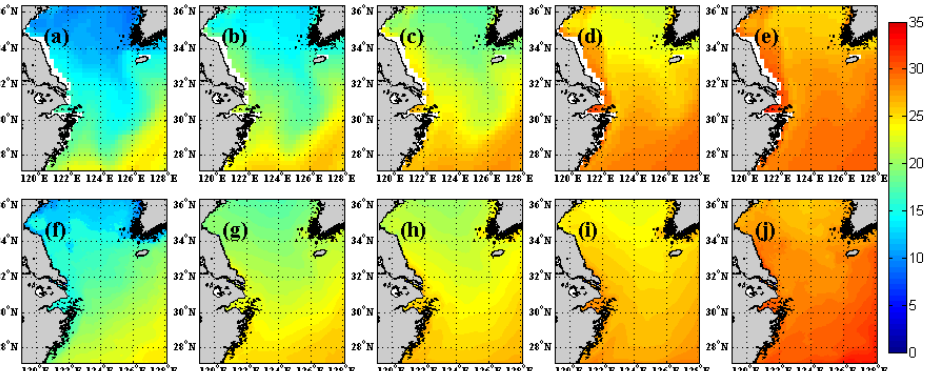
Figure 3. Monthly SST of ECCO2 from April to August (13-year average from 1998–2010) of Yangtze River estuary ( a – e , top row). The ( f – j ) are the same as ( a – e ), but for the model results. In addition to the spatial pattern, we also compare the time series of SST from model and ECCO2 averaged over 29° N – 32° N, 122.5° E – 124° E, which is a region where harmful algal bloom events happen frequently [47,50]. The model and ECCO2 (Figure 4) both show the gradual increase of SST from April to August, whereas the model tends to over- estimate SST by about 1 °C from April to June. Note that the temperature around the Yangtze River estuary is above 22 °C for the month of June to August, and the specific growth rate of phytoplankton equation of Case 5 will reach a maximum at 22 °C and keep as a constant for higher temperature. Thus, the model can reproduce the spatial pattern and seasonal variability of SST around the Yangtze River estuary.